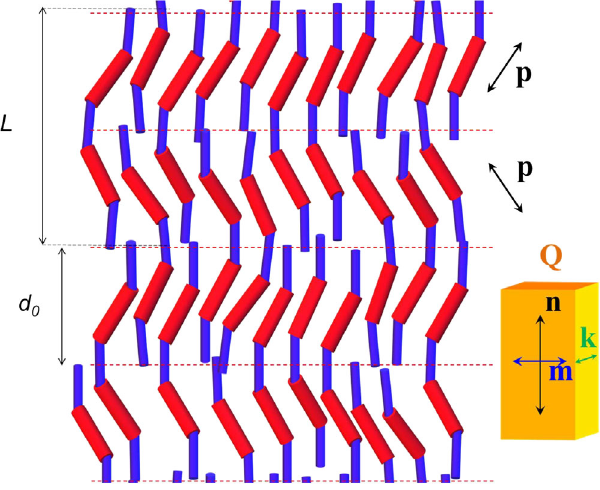
FIG. 3. Sketch of the structure of the M phase. The monomer X units form smectic liquid layers with thickness d 0 ≈ L= 2 . In each layer, the main axes p of the monomers are tilted in the same direction, and the sign of the tilt alternates from one layer to the next. The dimers span two adjacent layers and form an orthogonal intercalated smectic phase. The orientational order tensor Q of the dimers (shown in orange) is biaxial, with primary director n oriented along the layers normal and secondary director m parallel to the projection of p on the layer plane. ( k is the third director, which is perpendicular to both n and m